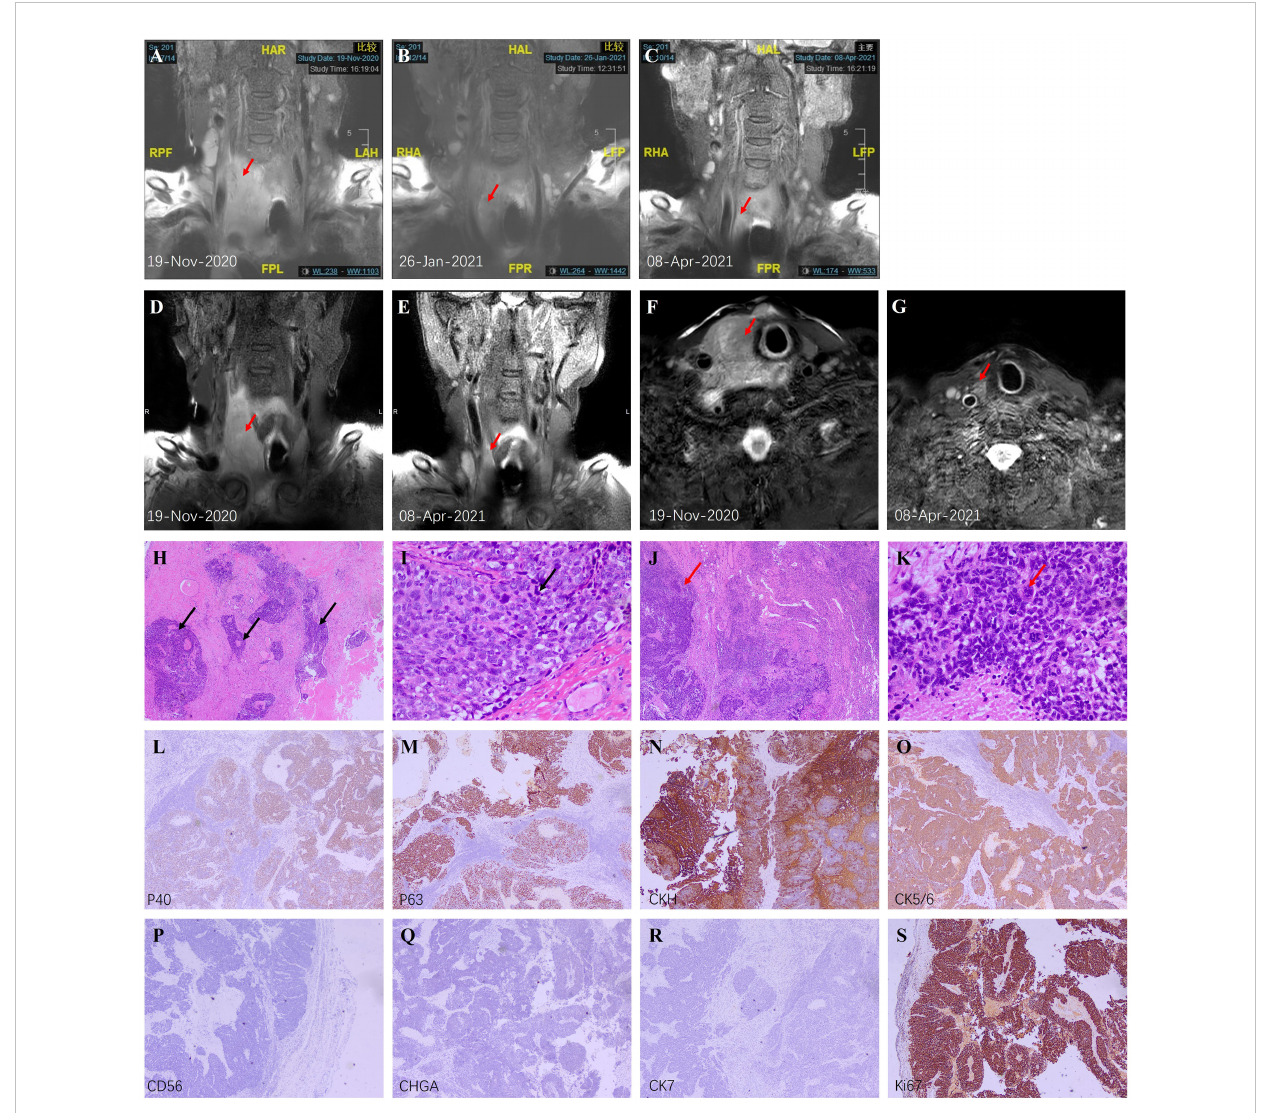
FIGURE 1 Imaging and pathological fi ndings. (A – C) Coronal T2-weighted MRI scans before treatment, after 2 courses, and after 5 courses; (D, E) Coronal high-resolution modi fi ed Dixon T1-weighted MRI scans of thyroid before and after 5 cycles; (F, G) Axial high-resolution modi fi ed Dixon T2-weighted MRI scans of thyroid before and after 5 cycles. The red arrows indicate the thyroid nodule. (H) Low magni fi cation of PSCCT (H&E, ×40) showed scattered islands of squamous cells (black arrows) with few typical follicular structures. (I) High magni fi cation of PSCCT (H&E, ×400) showed poorly differentiated tumor cells and typical nuclear heterogeneous cells (black arrows). (J) Low magni fi cation of right lymph node metastasis (H&E, ×40) showed diffuse proliferation of tumor tissue (red arrow). (K) High magni fi cation of right lymph node metastasis (H&E, ×400) showed epithelioid appearing neoplastic cells lacking differentiation, and abnormal mitotic fi gures (red arrow) could be seen. (L – S) Immunohistochemistry of the right lymph node metastasis (×40). P40 (L) , P63 (M) , CKH (N) , and CK5/6 (O) were positive, indicating the source of squamous cells. CD56 (P) and CHGA (Q) are markers of neuroendocrine cells, while CK7 (R) is a marker of adenocarcinoma. Negative results suggested the low possibility of these two sources. (S) Ki67 index was over 95% suggesting vigorous proliferation excluding simple squamous